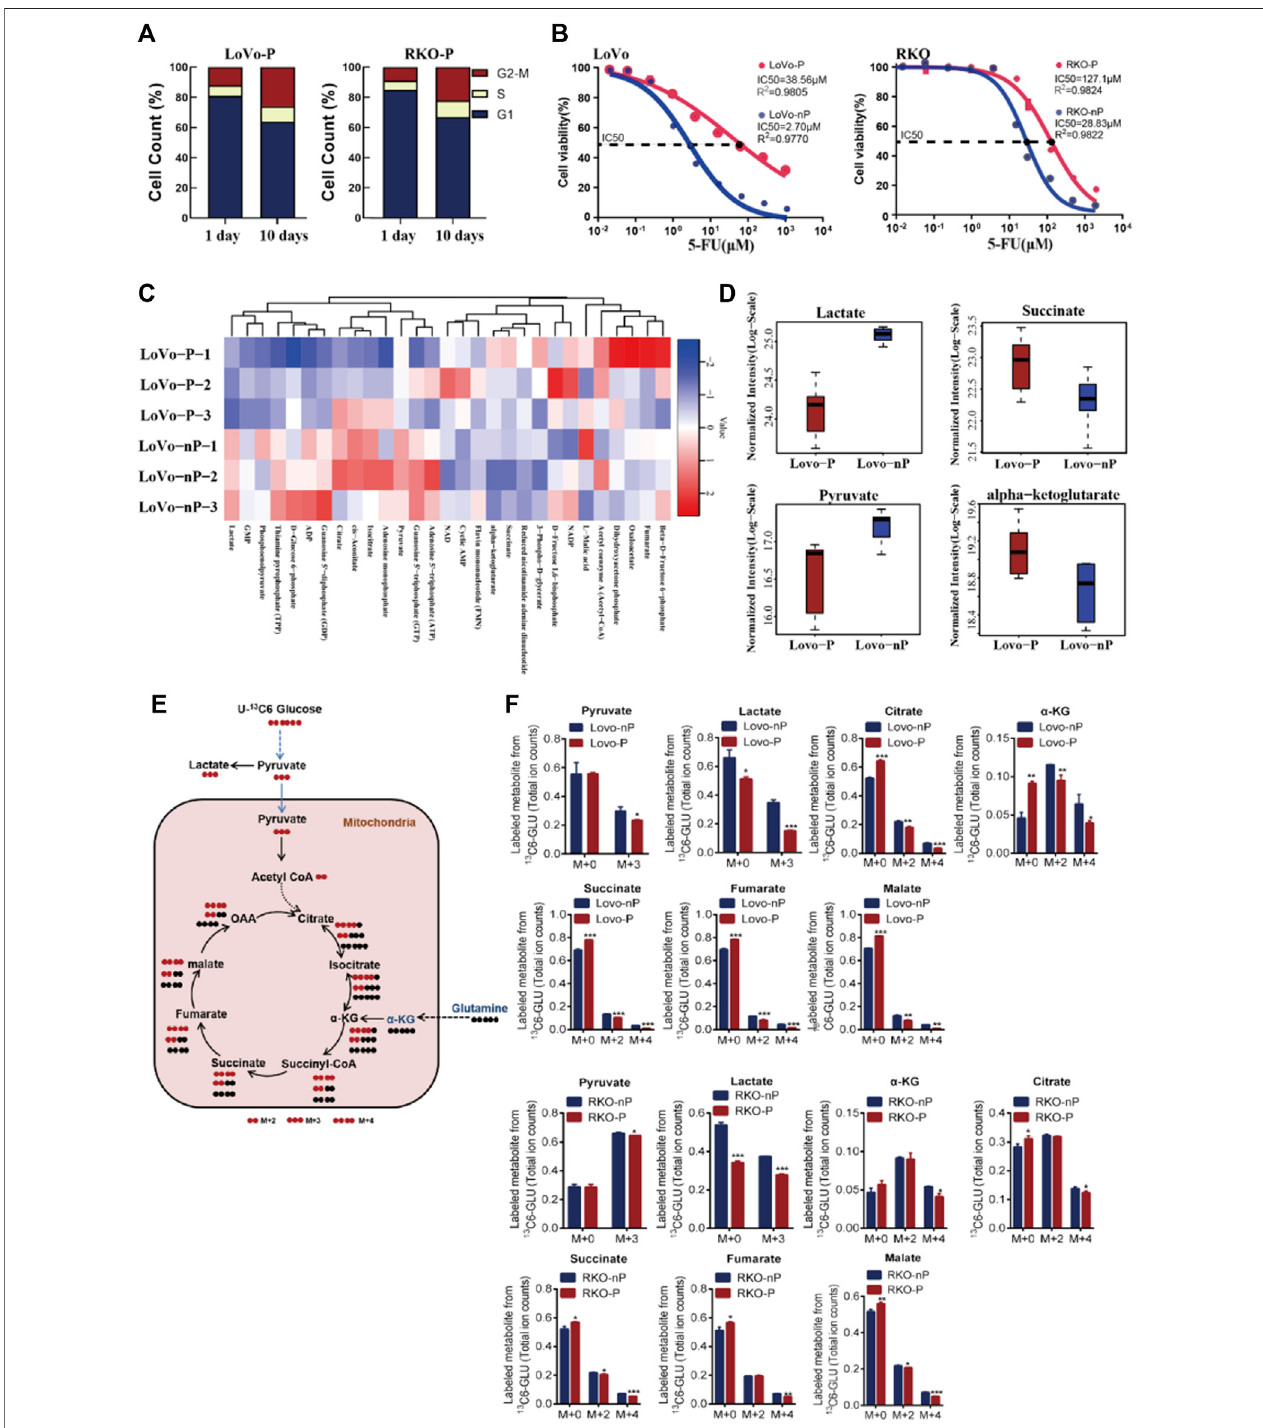
FIGURE 2 | (A) Distribution of cell cycle phases in LoVo-P and RKO-P cells on day 1 and 10 after treatment with 5-FU. (B) Half maximal inhibitory concentration (IC50) of 5-FU between DTP cells (LoVo-P and RKO-P) and parental cells (LoVo-nP and RKO-nP). (C) Heatmap of metabolites in the energy pathway determined by metabolomics in LoVo-P and LoVo-nP cells. The levels of energy metabolites are shown in Supplementary Table S1. (D) Compared to LoVo-nP cells, the main discriminant metabolite levels in LoVo-P cells. (E) Schematic illustration of glucose recycling using U- 13 C-glucose. (F) U- 13 C-glucose tracing analysis of LoVo and RKO DTP cells and parental cells. Cells were cultured in U- 13 C-glucose and DMEM for 24 h to synthesize U- 13 C metabolites ( n = 3). Bars, mean ± SD. * p < 0.05; ** p < 0.01; *** p < 0.001.